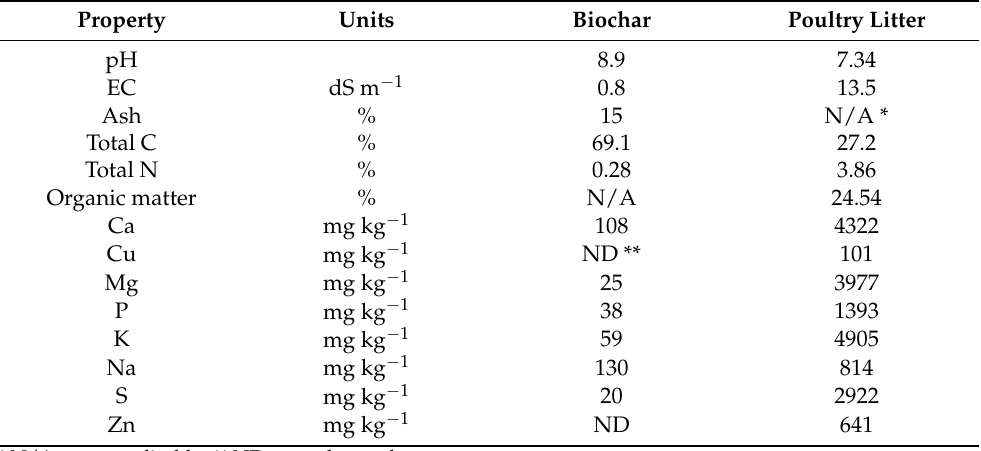
Table 1. Selected chemical properties of biochar and poultry litter applied to the experimental plots.